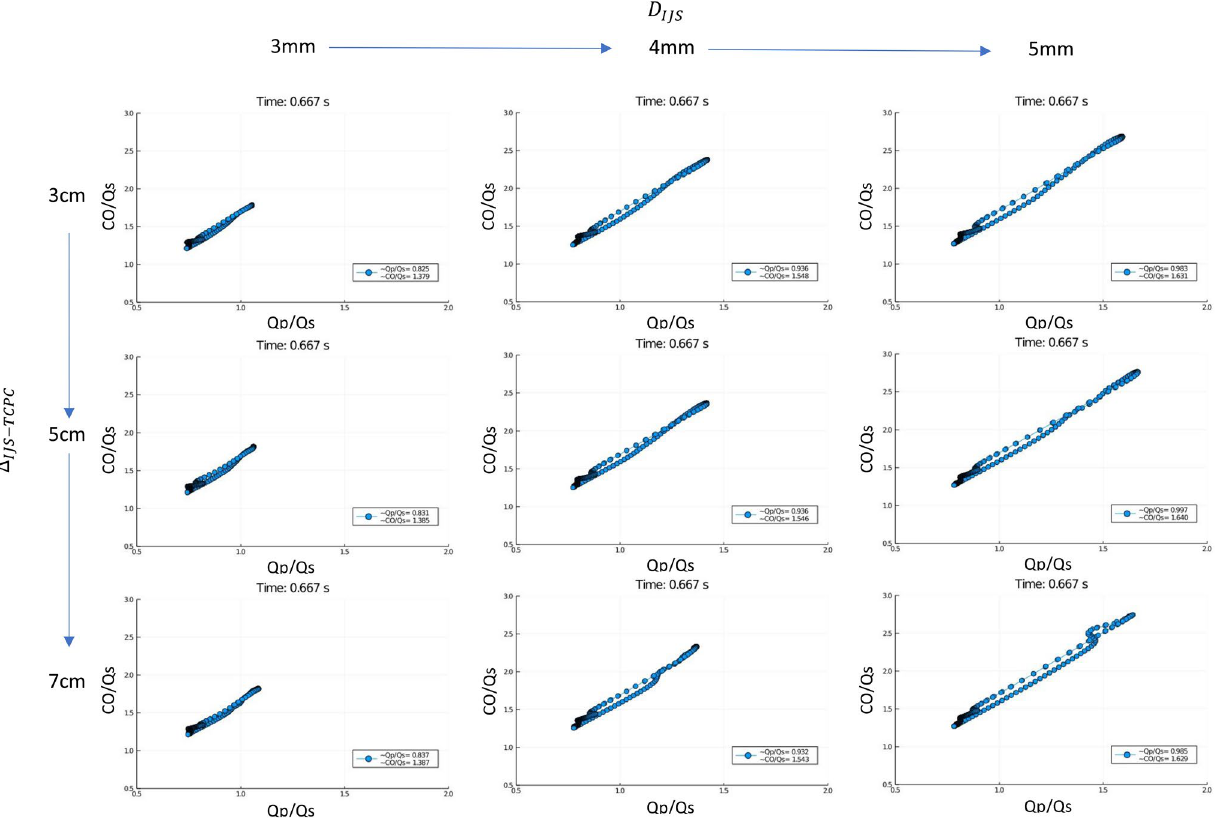
Figure 3. Hysteresis loops for preliminary parameter search from cases 3 to 11 in Table 1 for constant fenestration diameter and varying IJS diameter and IJS-TCPC distance (time-averaged Qp/Qs and CO/Qs are reported in the legend in each